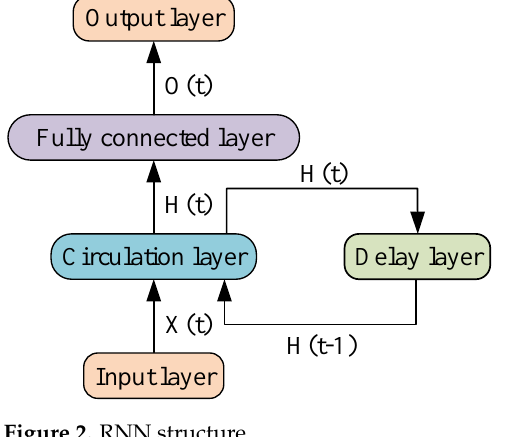
Figure 2. RNN structure.